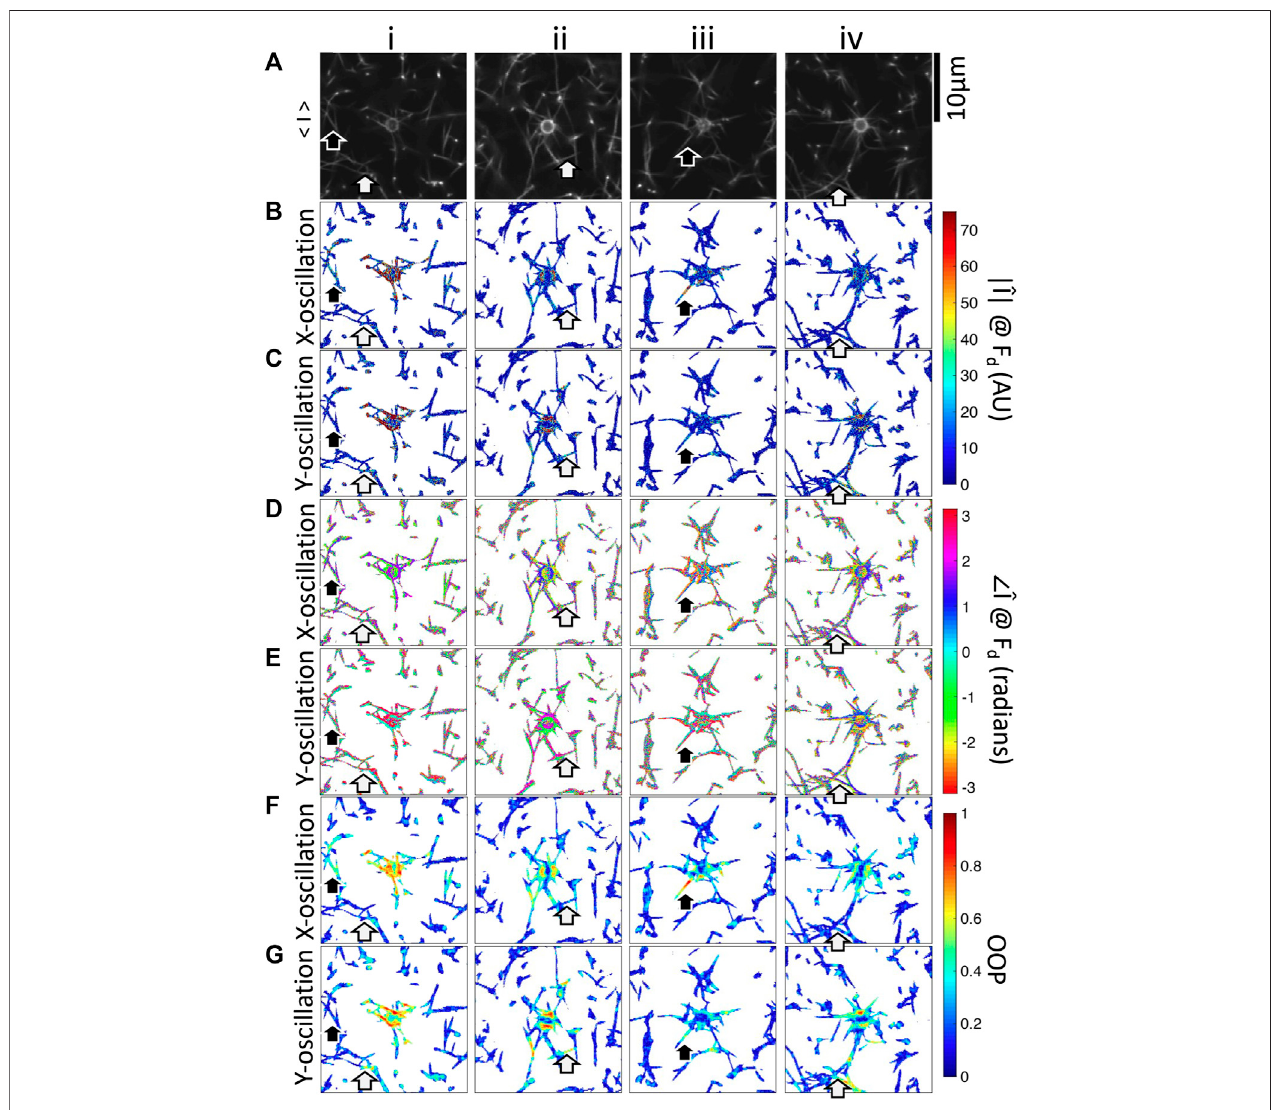
FIGURE 5 | Fourier magnitude, phase, and OOP images of four beads embedded in fi brin networks oscillated in the x -direction or y -direction. i – iv are different beads. (A) Fluorescence microscopy images showing the bead and fi bers. Mean-magnitude subtracted images at F d for oscillation in either the (B) x -direction or (C) y -direction.Phaseimagesat F d withoscillationineitherthe (D) x -directionor (E) y -direction.OOPimagesat F d ineitherthe (F) x -directionor (G) y -direction.Blackarrows indicate regions where the network responds more to oscillations in the y -direction while white arrows indicate the opposite.